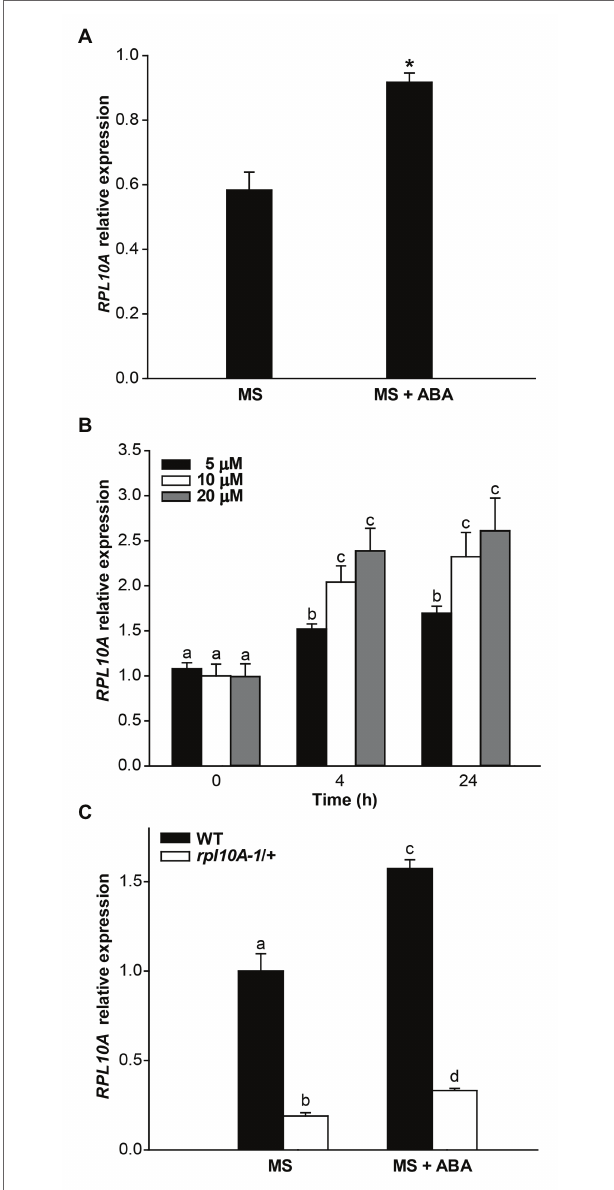
FIGURE 2 | Regulation of the RPL10A expression by ABA. (A) RPL10A transcript levels in WT seedlings, at cotyledon greening stage, grown in MS-agar medium (MS) or in MS-agar medium with 1 μ M ABA (MS + ABA), analyzed by RT-qPCR. Asterisks indicate statistical differences between conditions (Student’s t -test, p < 0.05). (B) RPL10A transcript accumulation in WT seedlings after ABA treatment (5, 10, and 20 μ M) for 4 and 24 h.